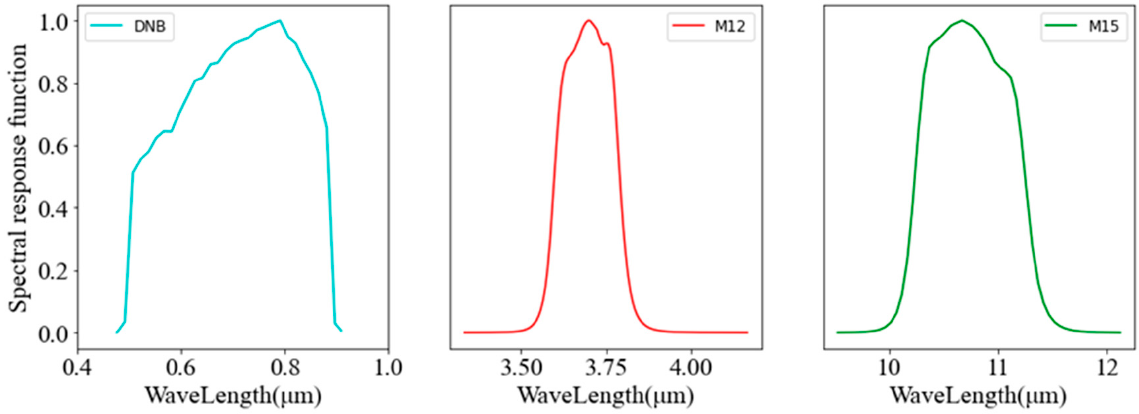
Figure 1. The DNB, M12, and M15 spectral response functions.